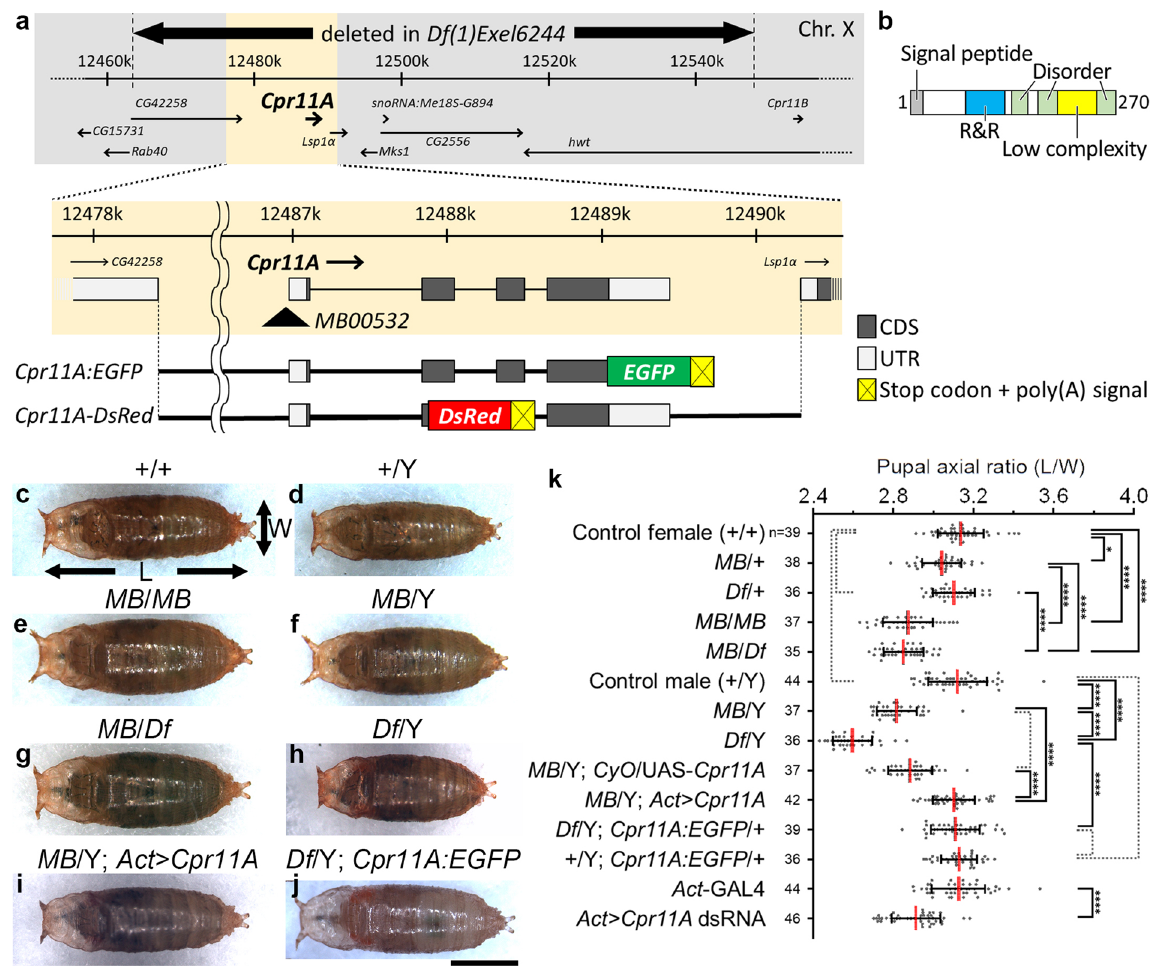
Fig. 1 Pupal shape variations caused by modulations of Cpr11A function. a Schematic representation of the Cpr11A locus (X chromosome), and mutations and transgenic constructs used in this study. The full-length Cpr11A protein fused at its C-terminus with EGFP is expressed from the Cpr11A : EGFP transgene. Nonsecretory DsRed is expressed from the Cpr11A-DsRed transgene. b Domain structure of Cpr11A. The signal peptide predicted by SignalP5.0 46 , the R&R domain (PF00379) by Pfam 49 , the low complexity region and the disorder regions by MobiDB 50 are shown. c – j Pupae of the indicated genotypes, viewed from the dorsal side. Anterior is to the left. The length (L) and the width (W) of a pupa were measured as indicated by arrows. MB , MB005322 ; Df , Df(1) Exel6244 ; Act > Cpr11A , Act -GAL4/UAS- Cpr11A ; Act > Cpr11A dsRNA, Act -GAL4/UAS- Cpr11A dsRNA. Bar, 1 mm. k Mean ± S.D. of pupal axial ratios (L/W) of individual genotypes. n, the number of pupae measured for each genotype. Signi fi cance was assessed using one-way ANOVA ( p < 0.0001) and Tukey ’ s multiple comparisons test. * p < 0.05; **** p < 0.0001; broken brackets, not signi fi